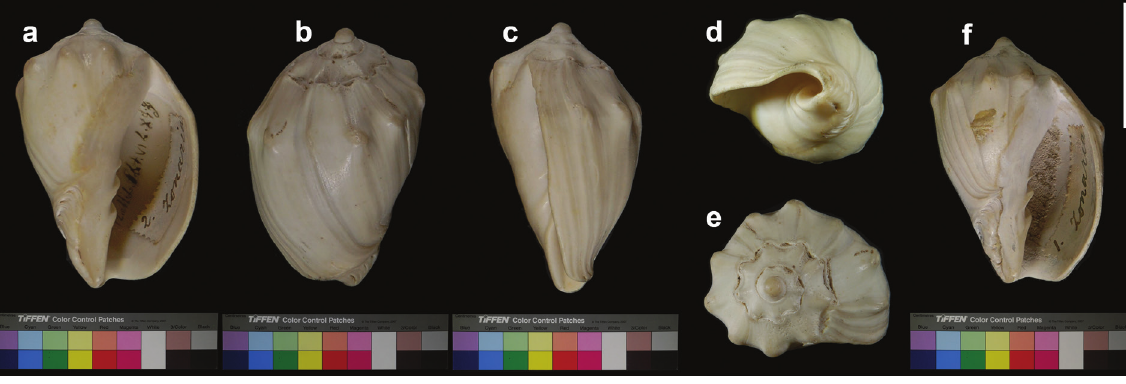
Figure 35. Syntypes of Voluta colocynthis lactea . a–e Specimen figured by Lahille (1895: pl. X, fig. 3) a Apertural view b Dorsal view c Lateral view d Umbilical view e Apical view f Specimen figured by Lahille (1895: pl. X, fig. 1) in apertural view. Scale bar: 3